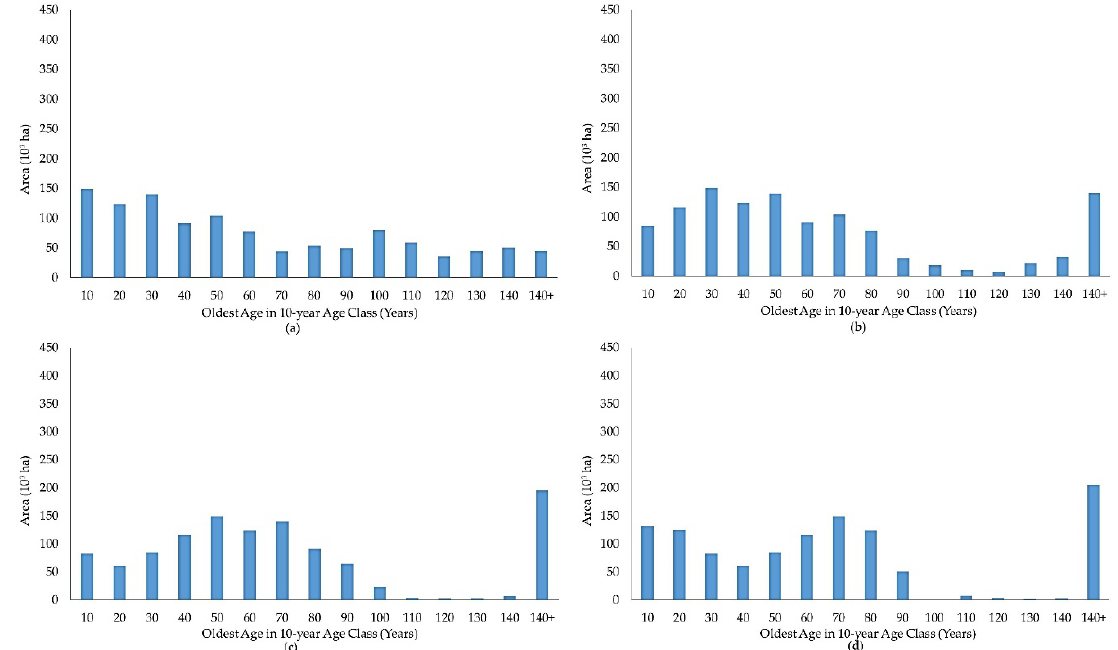
Figure 11. Oak and northern hardwood age-class distribution under the lowest old forest marginal value function at year 40 ( a ), 60 ( b ), 80 ( c ), and 100 ( d ) of the 100-year planning horizon.